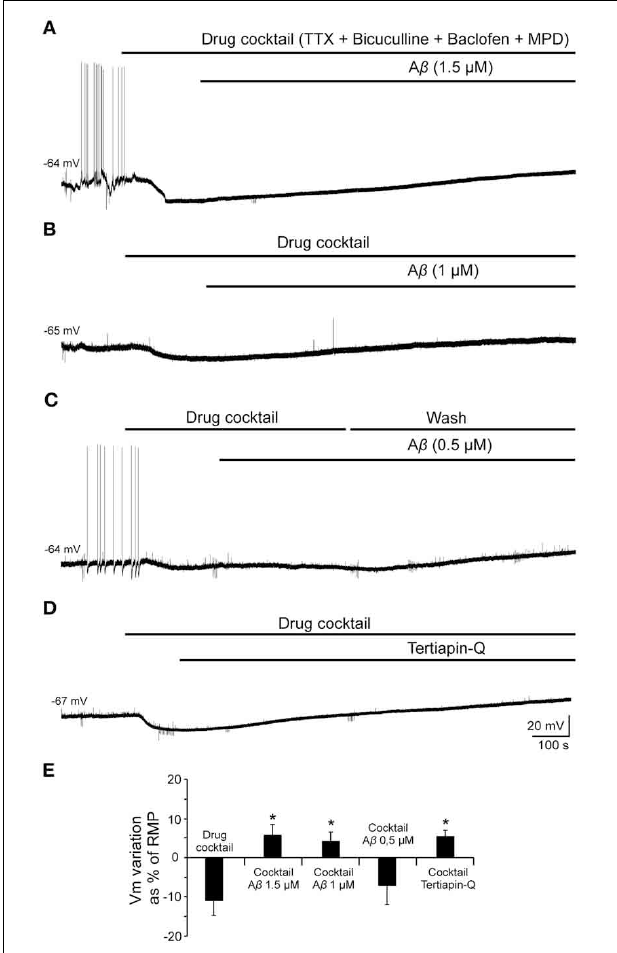
FIGURE 9 | Effects of A β 25 – 35 perfusion on the response evoked by pharmacological co-activation of GirK channels and GABA B receptors. (A,B) GirK/GABA B postsynaptic hyperpolarization was induced ( n = 15) by perfusion of drugs cocktail including TTX (1 μ M; voltage-dependent sodium channels blocker), bicuculline (10 μ M; specific blocker of GABA A receptors), baclofen (15 μ M; agonist of GABA B receptors), and MPD (50mM; GirK channel agonist) perfusion. A β 25 – 35 1.5 μ M ( n = 3) and 1.0 μ M ( n = 4)( A and B, respectively) evoked a postsynaptic depolarization. (C) Using the same protocol, A β 25 – 35 0.5 μ M was not able to produce this depolarization. The cocktail hyperpolarizing effect on membrane potential disappeared after cell washing with bathing solution ( n = 4). (D) Tertiapin-Q ( n = 4; 0.5 μ M; selective blocker of GirK channels), the specific antagonist of GirK channels, induced a depolarization of the postsynaptic hyperpolarization mediated by